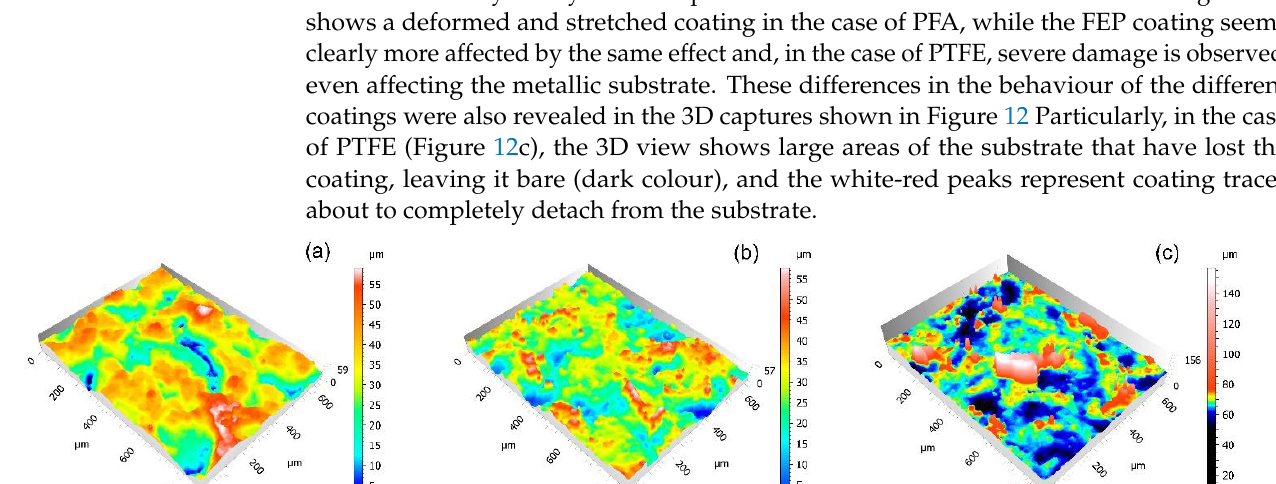
Figure 12. 3D topographic captures (×20 confocal lens, Leica DCM8 high-definition microscope) of the coatings after projection of 4 s with plastic particles at 0.4 MPa: ( a ) PFA, ( b ) FEP, and ( c ) PTFE.